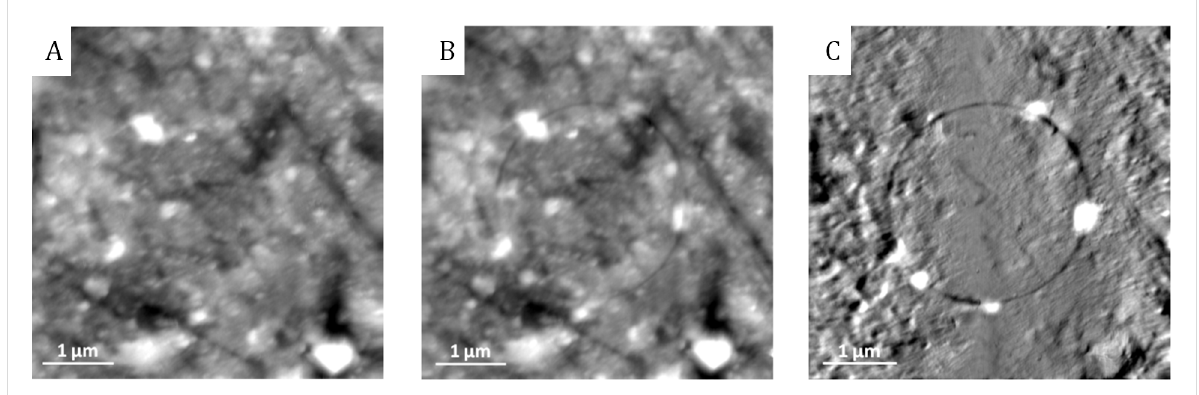
Figure 4: A and B (grey scale is 35 nm) are the AFM contact mode topographic images before and after the wear experiment; C (grey scale is 12 nm) is the height difference (B) − (A) obtained on a copper-based composite (image size: 5 × 5 µm).